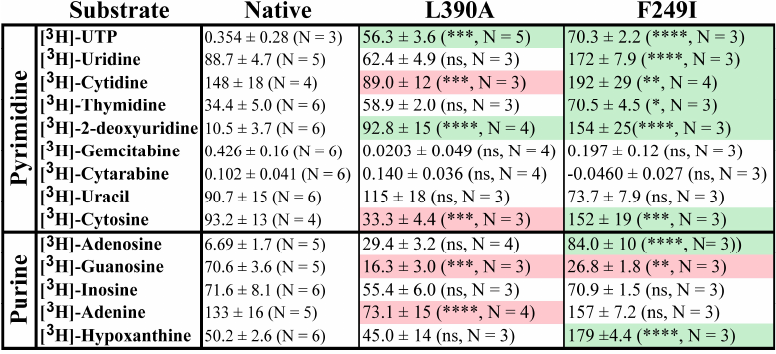
Figure 1. Comparison of the uptake of radiolabeled substrate by Native ScENT1 and L390A and F249I mutants. Substrates have been classified based on containing a pyrimidine or purine nucleobase and data represents the mean substrate uptake (pmol substrate/mg of ScENT1) for each substrate tested at 100 nM final concentration in the assay sample mixture, N -values are indicated next to each substrate in the figure. PLs were incubated with radiolabeled substrate for 3.5 h followed by vacuum filtration onto membranes. Error bars represent the S.E.M. Statistical significance of the L390A and F249I PLs was determined by comparing the mean substrate uptake for each individual substrate to the mean substrate uptake of the respected Native PLs using two-way analysis of variance and Dunnett’s multiple comparison test [ 3 H]-cytarabine uptake for the Native PLs was used as a reference. Statistically significant changes are denoted in red (decrease) or green (increase) relative to Native ScENT1. Negative control PLs and substrate specific activity are included in the pmol substrate/mg ScENT1 calculation for each sample. ns, not significant; * p < 0.05; ** p < 0.01; *** p < 0.001; **** p <